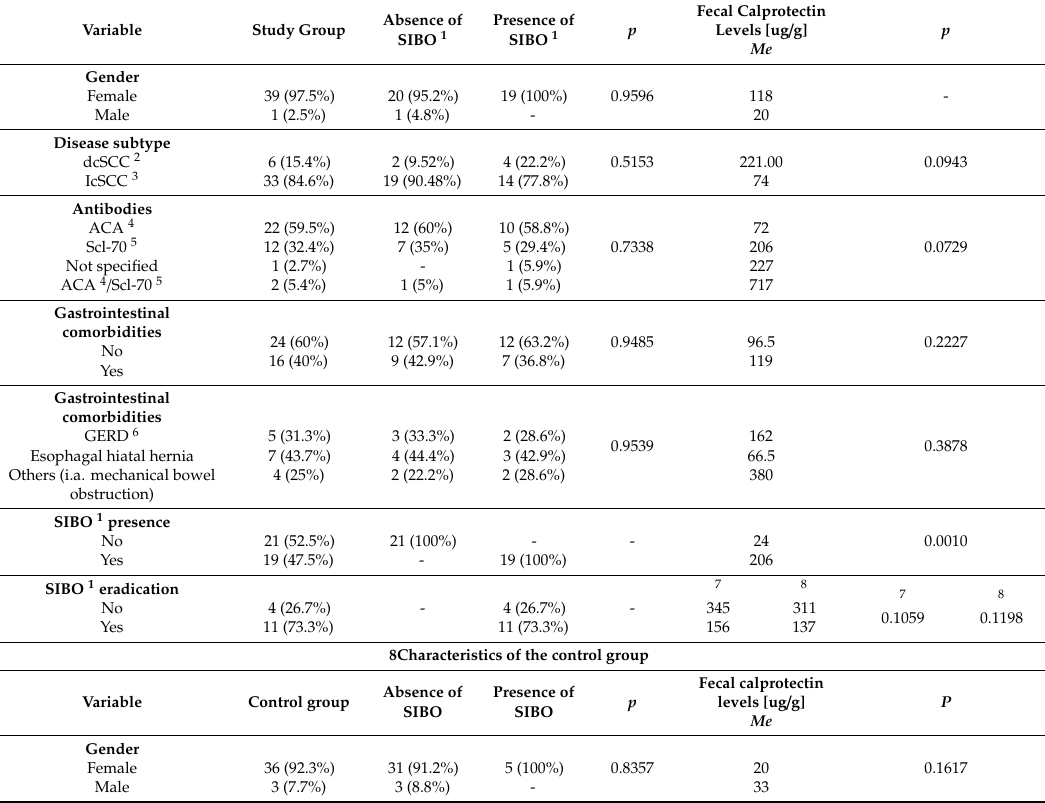
Table 1. Characteristics of the study and control groups including SIBO and fecal calprotectin